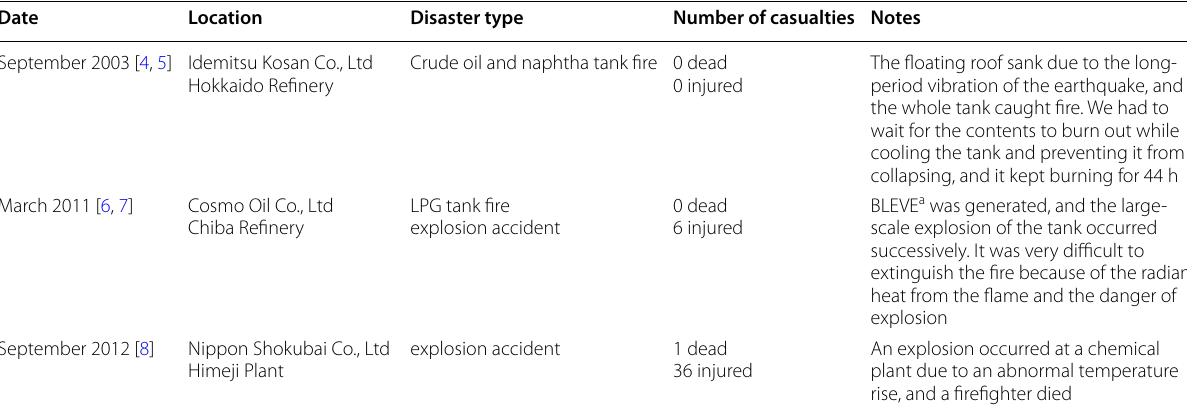
Table 1 Recent serious disasters in Japan with difficult-to-extinguish fires